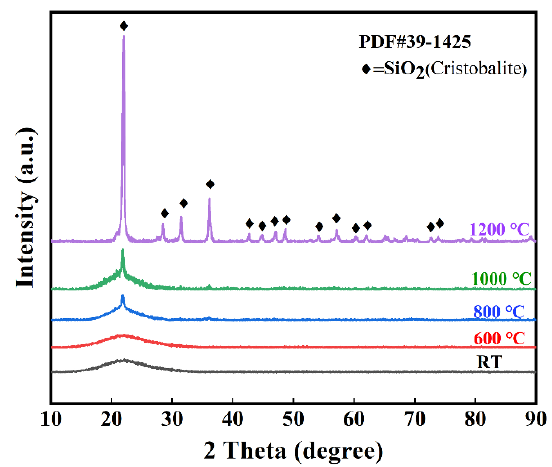
Figure 10. X-ray diffraction patterns of SiO 2 fibrous porous ceramics before and after heat treatment at different temperatures.